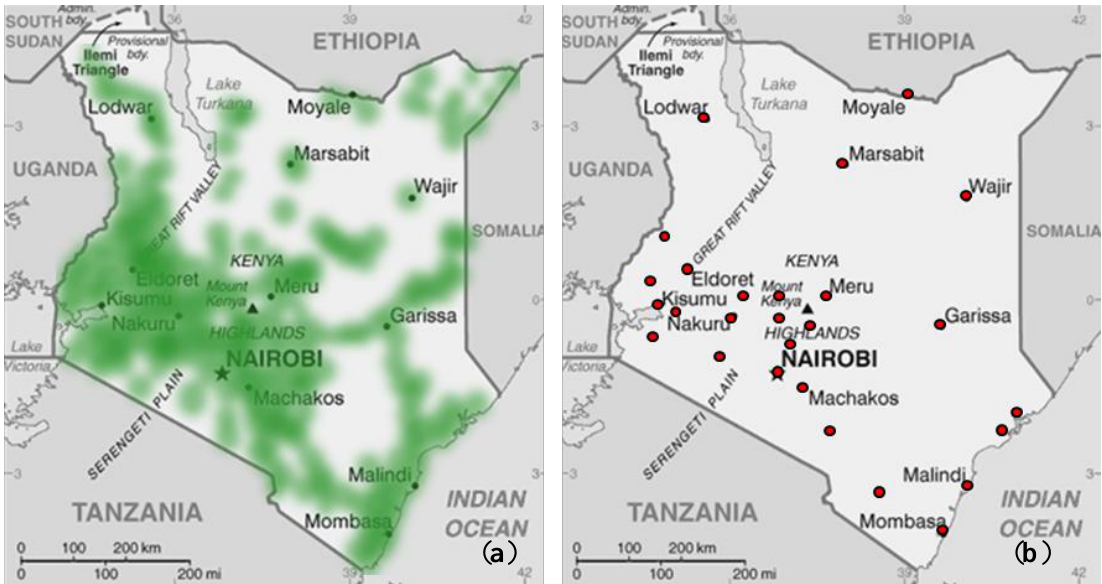
Figure 1. ( a ) Safaricom cover in Kenya (shaded green). ( b ) Locations of the automated weather stations of the Kenya Meteorological Department (red